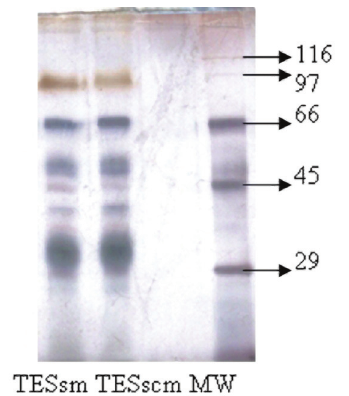
FIGURE 1 - Toxocara excretory-secretory antigens: TESsm: Sigma membrane, or TESscm: a sausage-casing membrane, in a 10% sodium dodecyl sulfate polyacrylamide gel (SDS- PAGE) with silver staining; MW- standard marker for molecular weight TABLE I - Absorbances of the positive serum control in the Enzyme-Linked Immunosorbent assay (ELISA) with plates coated with Toxocara excretory-secretory antigens TESsm and TESscm TESsm Serum Dilution